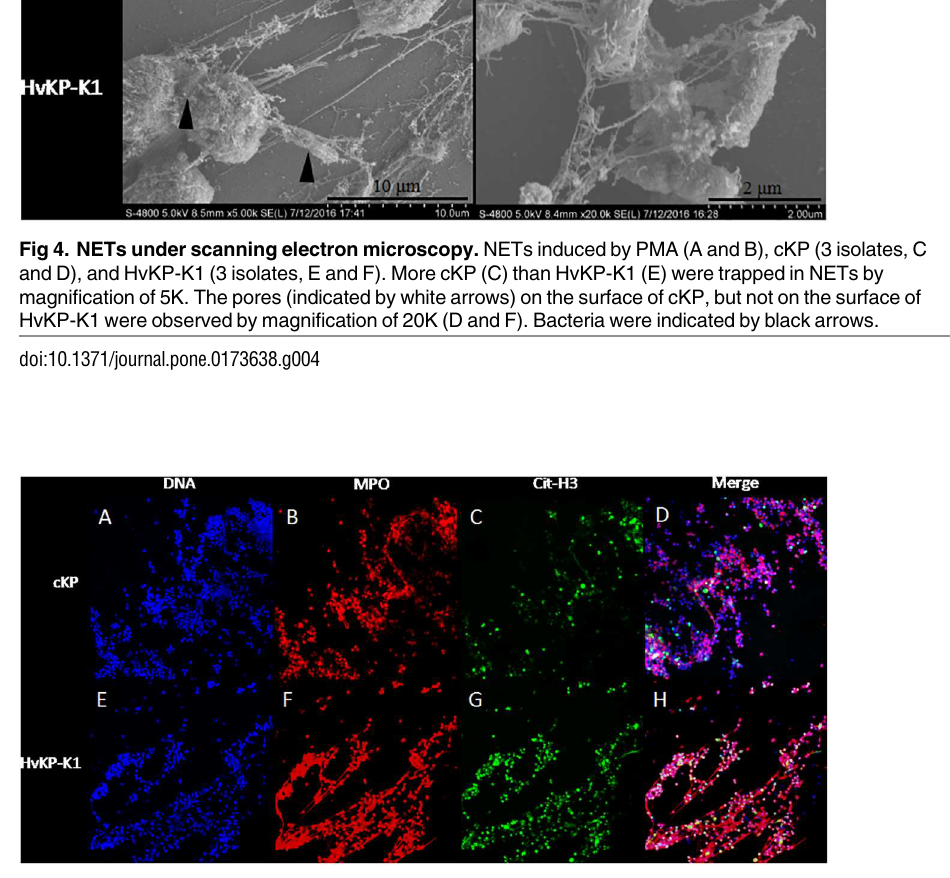
Fig 5. Immunofluorescencestaining under confocal microscopy. Neutrophilschallengedby cKP (9 isolates, A-D) and HvKP-K1 (9 isolates, E-H) were stainedfor DNA (DAPI, blue, A and E), myeloperoxidase (MPO, red, B and F) and citrullinated histone H3 (cit-H3, green, C and G). The merged images of cKP (D) and HvKP-K1 (H) illustratedthe characteristic neutrophilextracellular traps. Originalmagnification 40 × .